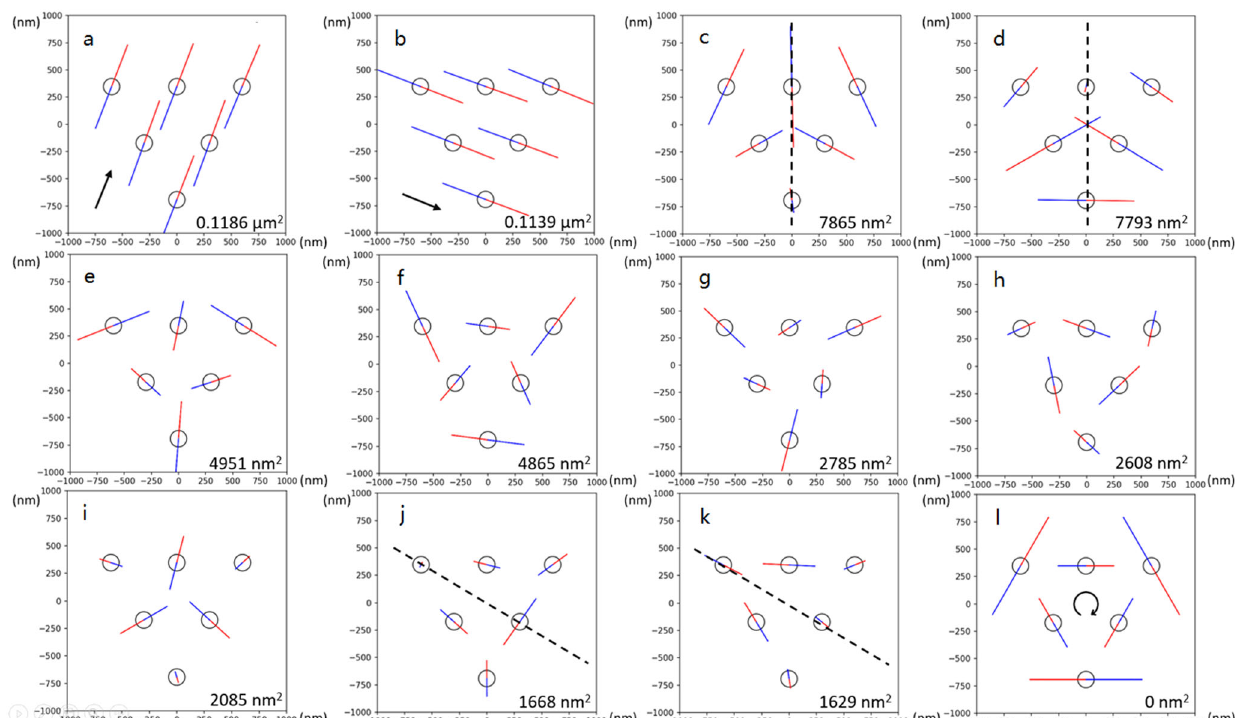
Fig. 4 Principal components of the 6-particle triangle con fi guration. Panels a – l correspond to PC 1 to 12, respectively. The colored solid lines depict the directions and magnitudes of the collective particle motions, and the color de fi nes the sense (i.e. phase) of the motion; i.e., particles simultaneously move in the indicated directions for the same color. PCs 1 and 2 correspond to rigid translation and PC 12 to rigid rotation. For the non-rigid transformations, PCs 3 – 11, the length of the solid lines is proportional to the PCA eigenvalues, λ i , which are reported in the bottom right of each panel. The value of the 12 th eigenvalue is exactly zero due to elimination of rotational motion in application of PCA. Dashed black lines represent axes of symmetry. Black arrows indicate global translational or rotational motions.